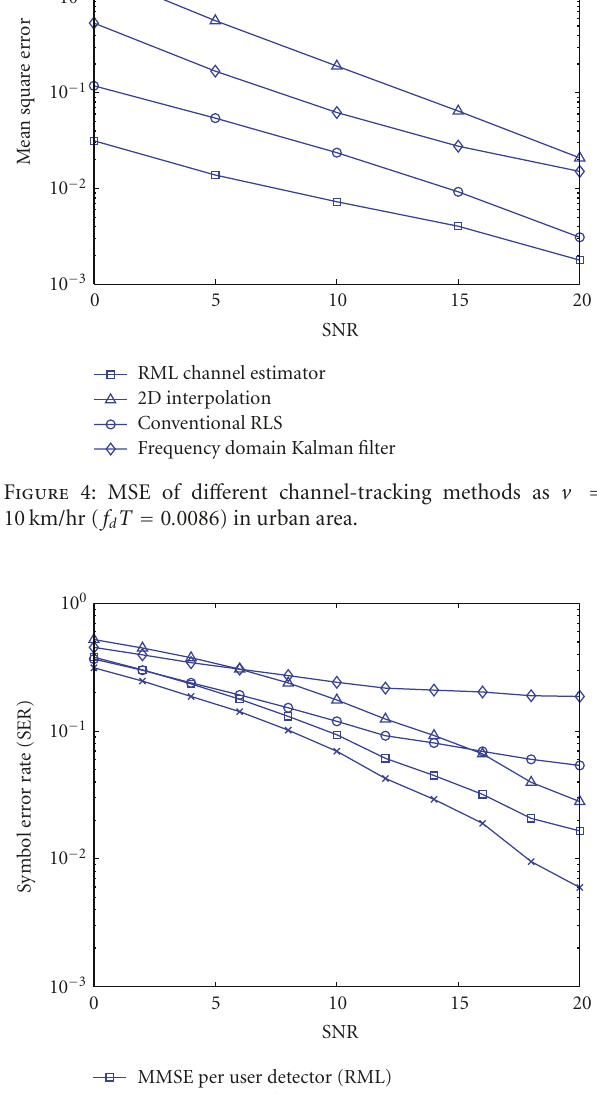
Figure 4. The proposed RML estimator has the lowest MSE, performance with the perfectly known